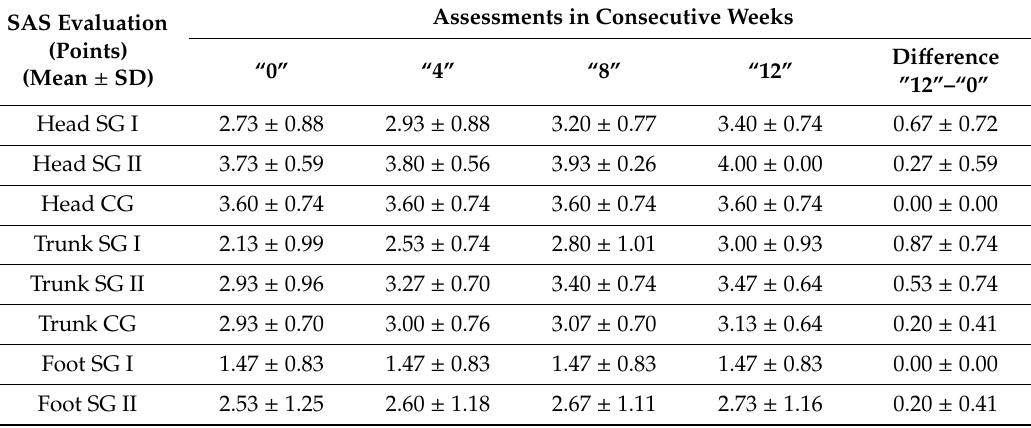
Table 2. Comparison of the average values of points in the Sitting Assessment Scale (SAS), for the study groups (SG) and the control group (CG), during the 12 weeks of the